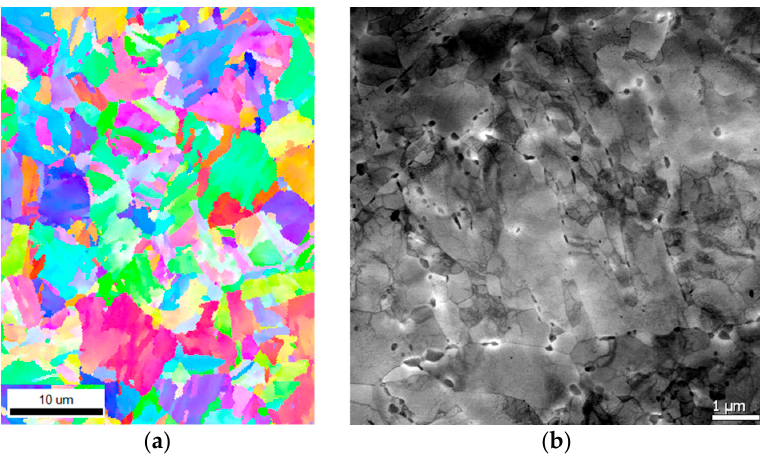
Figure 1. ( a ) EBSD image showing random distribution of grain orientations, and ( b ) TEM image showing the second phase particles located both inside grains and at grain boundaries. The material is ferritic based steel and both images were taken before deformation.